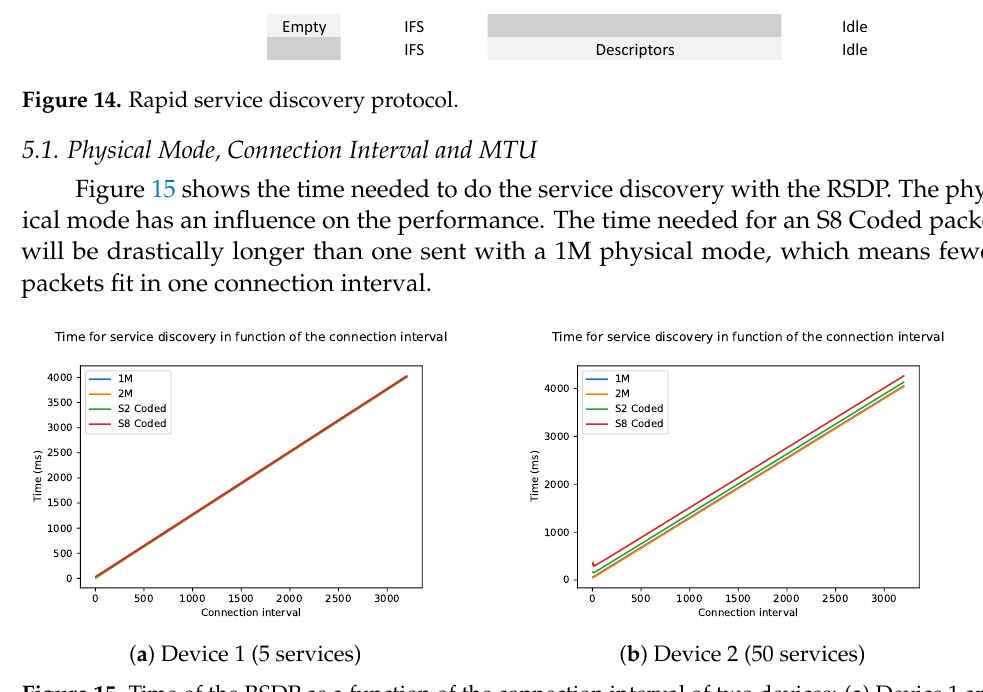
Figure 15. Time of the RSDP as a function of the connection interval of two devices: ( a ) Device 1 and ( b ) Device